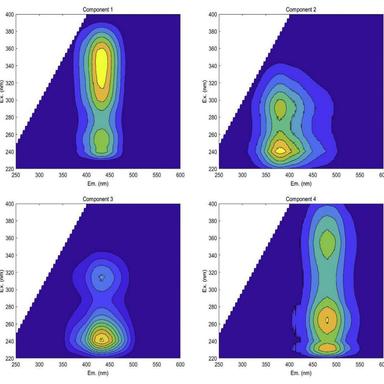
Deconvoluted PARAFAC components.